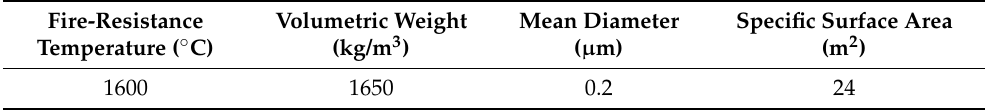
Table 2. The main technical indexes of silica fume.